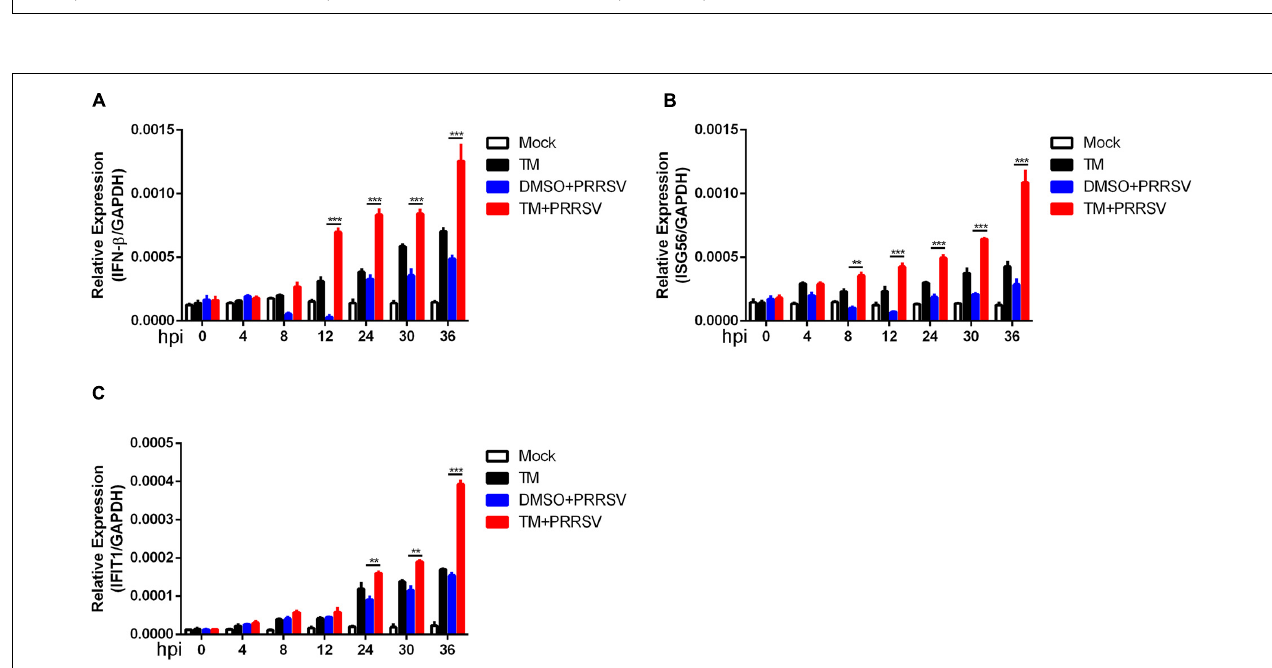
FIGURE 3 | Induction of UPR accelerates the expression of interferon following PRRSV infection. Marc-145 cells were mock-infected or infected with PRRSV (MOI = 1) in the presence or absence of TM (1 µ g/ml) for indicated time (0, 4, 8, 12, 24, 30, and 36 hpi). DMSO serves as a negative control. The relative expression of IFN- β (A) , ISG56 (B) , and IFIT1 (C) were analyzed using qRT-PCR. Data are normalized to GAPDH in each sample. Data are the results of three independent experiments (means ± SE). Significant differences are denoted by * p < 0.05, ** p < 0.01, and *** p < 0.001.